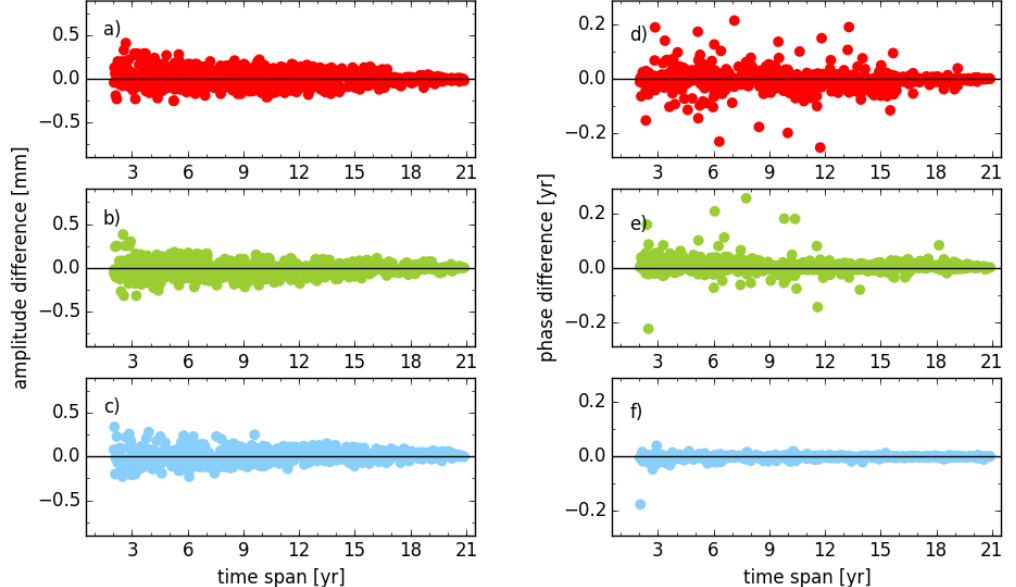
Figure 2. Amplitude and phase differences of the annual signal between solution unit_xxx_s2 and unit_tr_s2 for stations with different observation time spans; ( a , d ) for east; ( b , e ) for north; ( c , f ) for vertical components.